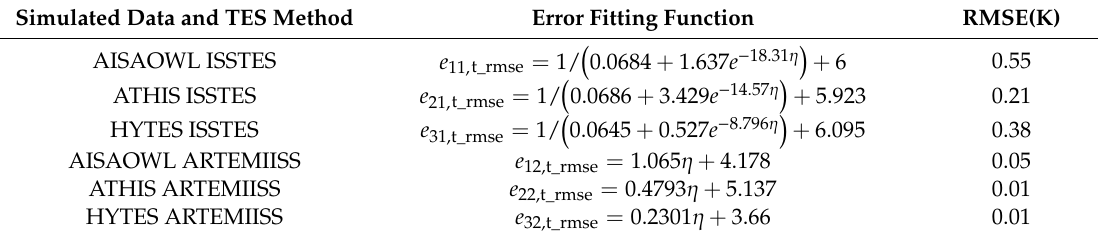
Table 7. The LST error fitting function about NEDT.